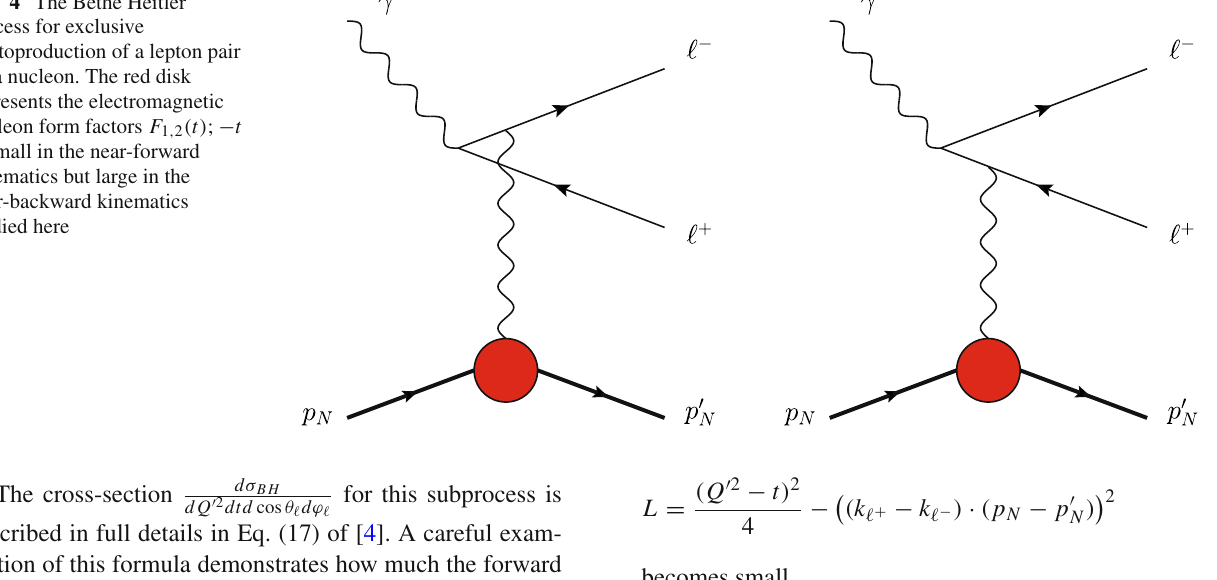
the hadronic and leptonic planes. The lepton polar angle θ (cid:6) is defined between (cid:10) k (cid:6) + and (cid:10) p (cid:4) in the (cid:6) + (cid:6) − -CMS frame. The lepton azimuthal N angle ϕ (cid:6) can be chosen to coincide with ϕ ∗ since a boost along z (cid:4) does not change the momentum components transverse with respect to z (cid:4)